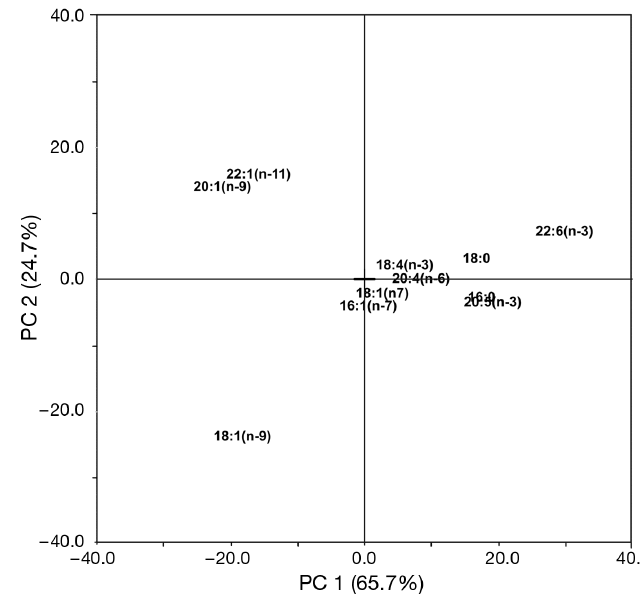
Fig. 4. Salmo salar . Loading plot of principal component (PC) analysis of fatty acids in total lipids and triacylglycerols in the adi- pose fin and muscle of wild salmon (see score plot in Fig. 3). Fatty acids closer to the origin are not